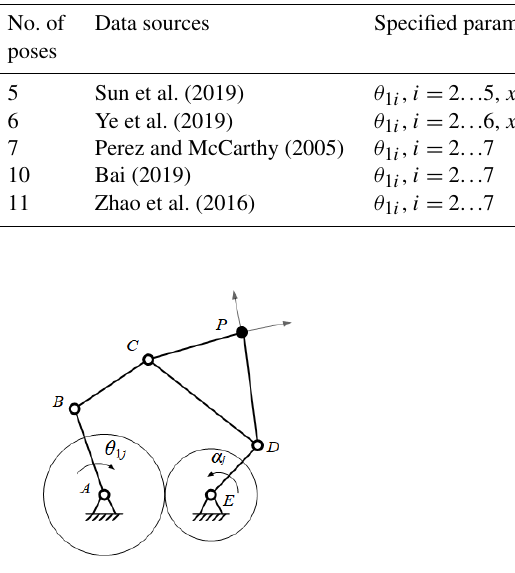
Figure 7. Geared five-bar mechanism.